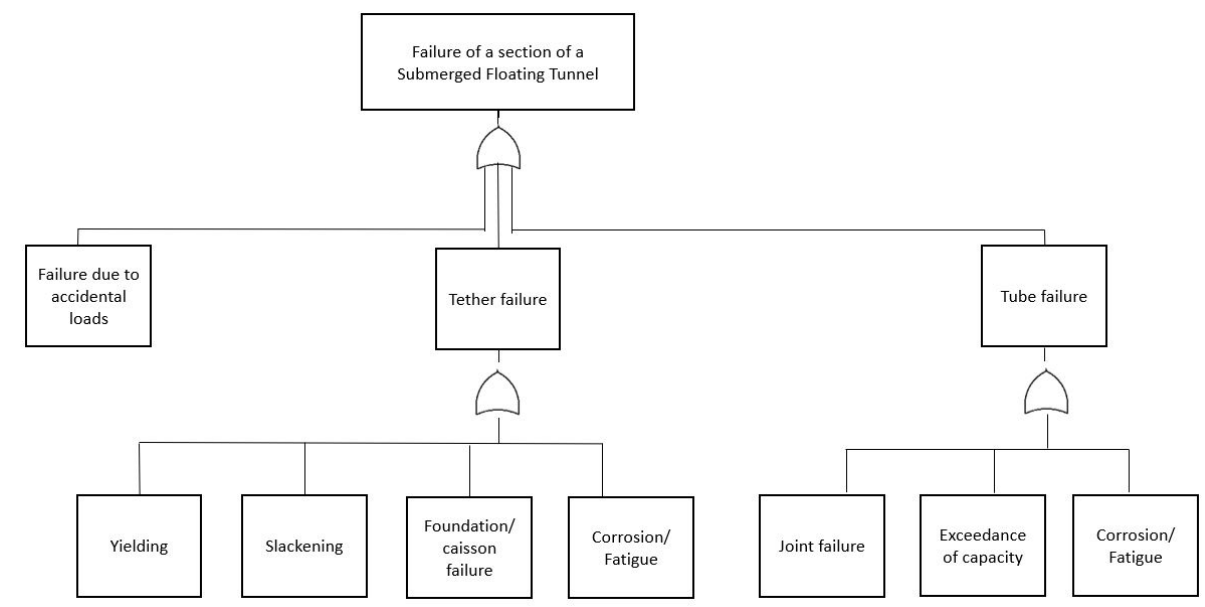
Figure 4. Fault tree for an